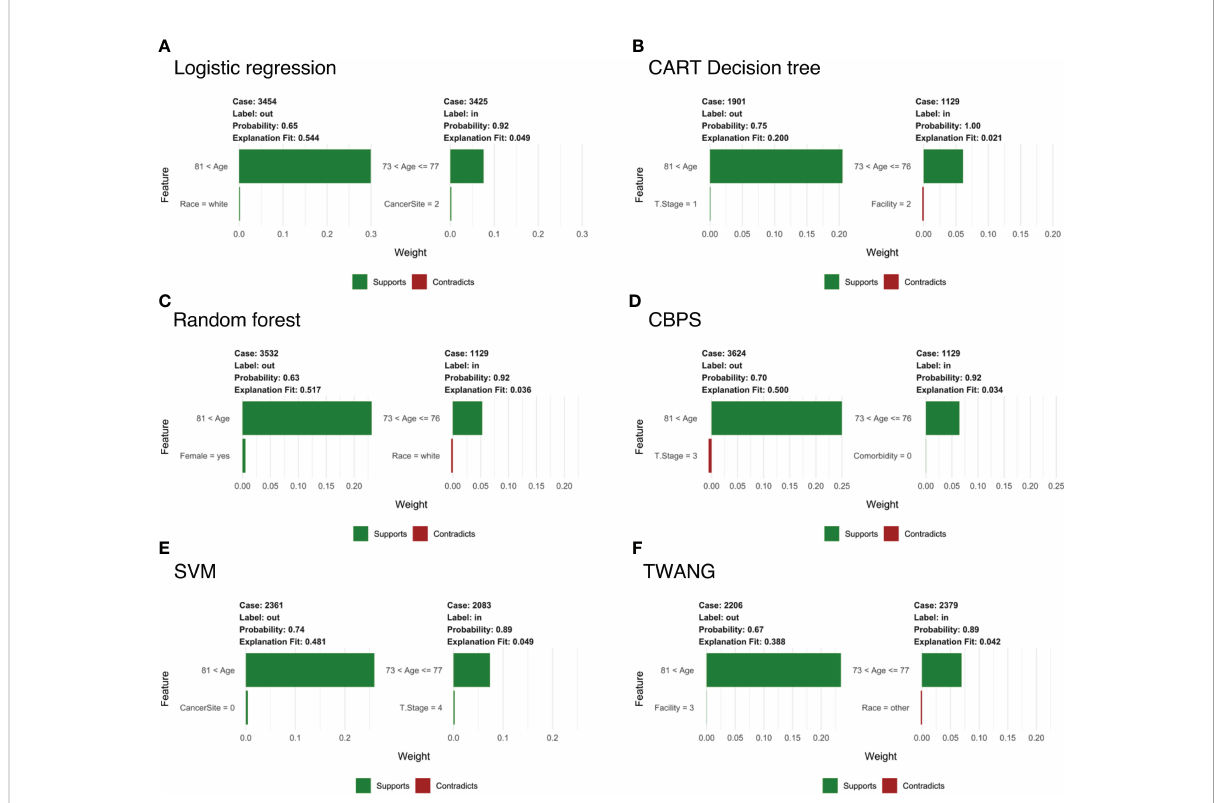
FIGURE 3 Subject-level Local Interpretable Model-Agnostic Explanations for head and neck cancer data for propensity scores estimated by (A) logistic regression; (B) CART decision tree; (C) random forest; (D) covariate balancing propensity scores; (E) support vector machines; and (F) the Toolkit for Weighting and Analysis of Nonequivalent Groups. Each graphic identi fi es the most deterministic individual-level features in classifying matched ( “ in ” ) or unmatched ( “ out ” ) status and notes whether this trait supports or contradicts the probability ascribed by the decision tree. Weights indicate how strongly representative each feature is of the classi fi